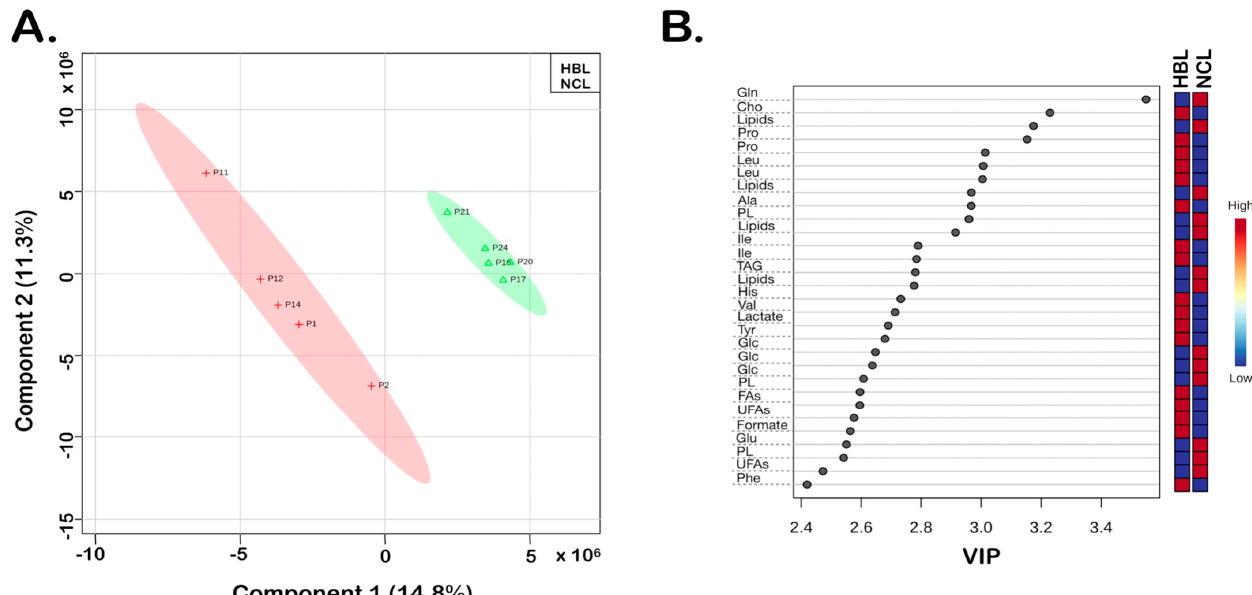
Figure 2. HBL vs. NCL. PLS-DA of the HR-MAS 1 H-NMR CPMG data: ( A ) 2D score plot shows 15 HBL and 15 NCL samples; statistical parameters were as follows: accuracy (0.68), R 2 (0.77), and Q 2 (0.39). ( B ) Variable importance in projection (VIP) scores greater than 2.35 were assigned to important metabolites 1–16, as summarized in Table 1, which are discriminatory for HBL vs. NCL in the PLS-DA model. HBL tissue samples are shown with red crosses and the non-cancer liver tissue samples (NCL) are shown in green triangles.